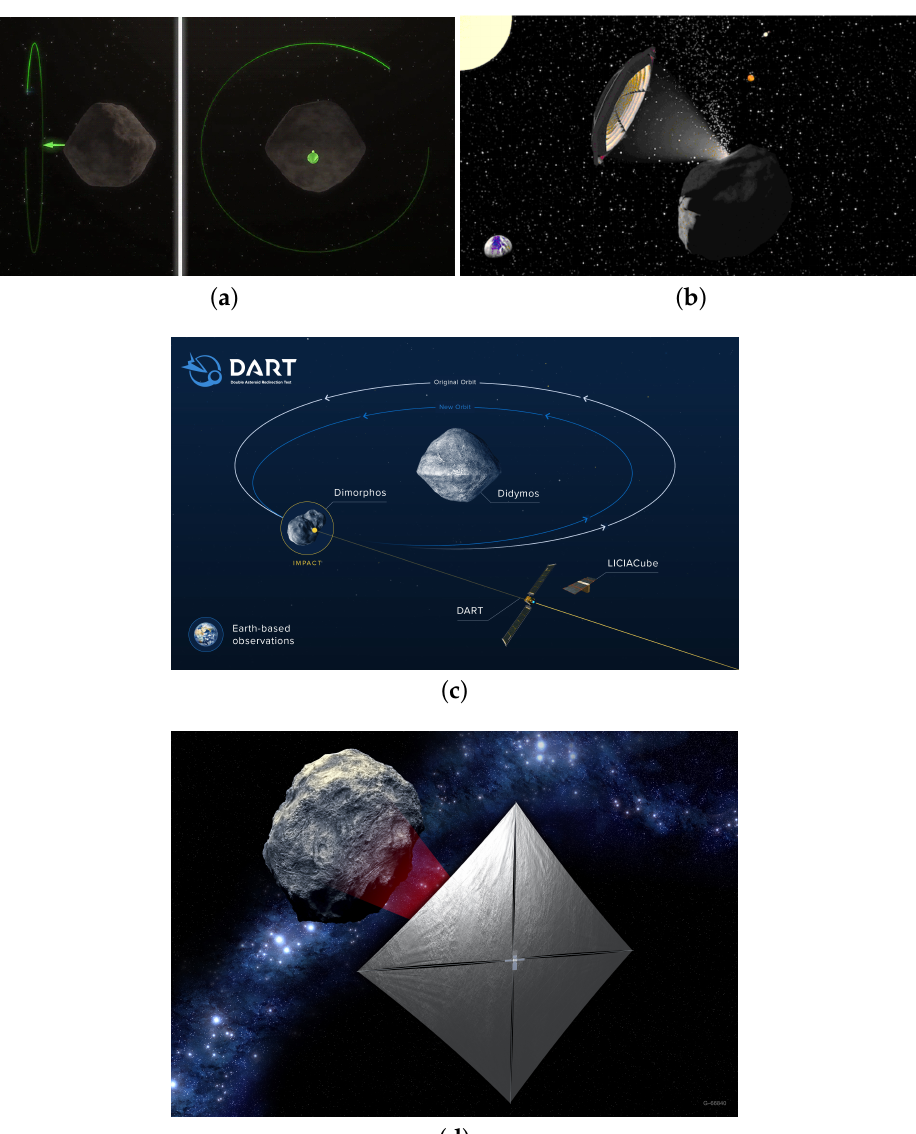
Figure 18. Illustration of various mitigation technologies of: ( a ) gravity tractor [155]; ( b ) focused solar energy [156]; ( c ) the deployment scheme of DART mission [157]; and ( d ) the conceptual design of solar sail